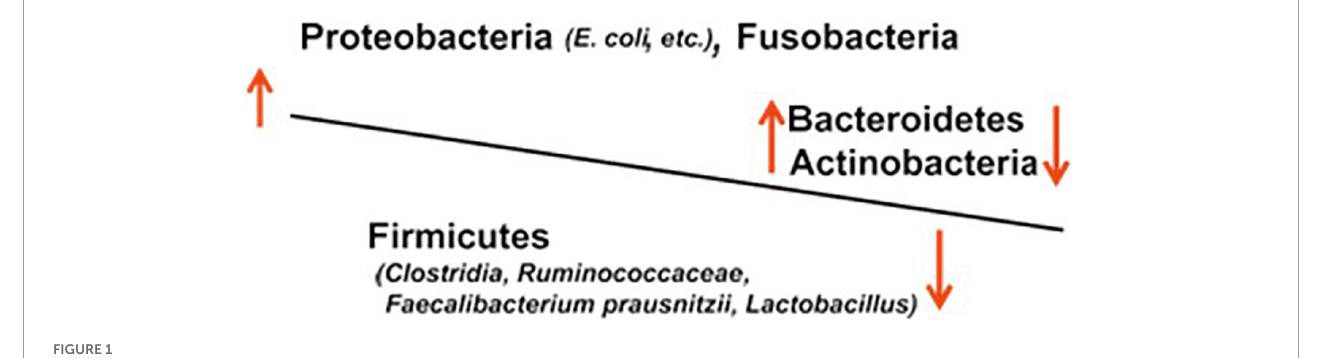
FIGURE1 Dysbiosis of the gut microbiota in